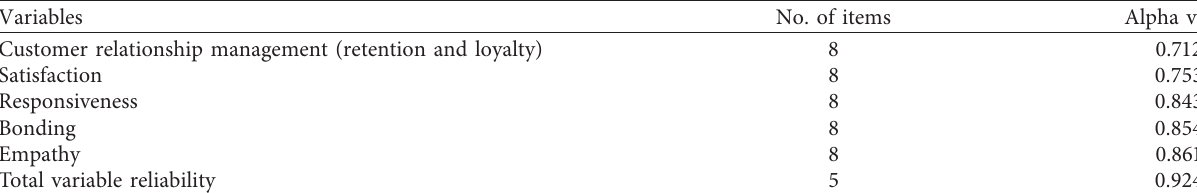
Table 1: Reliability statistics.